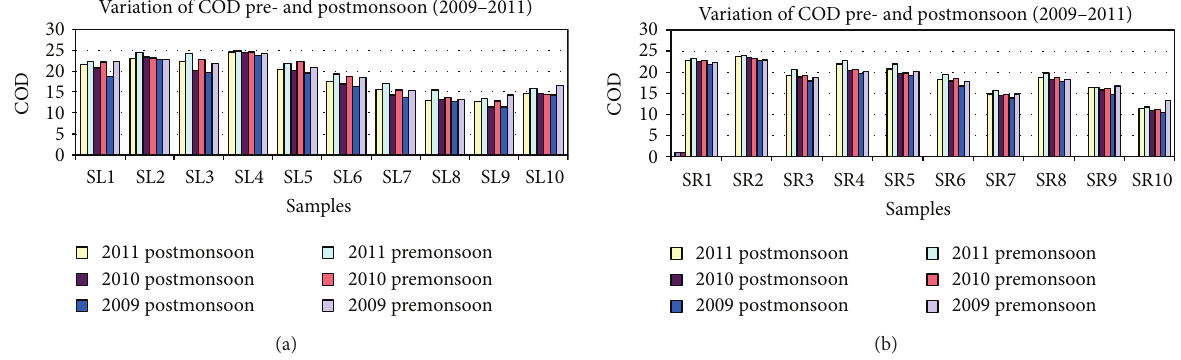
Figure 6: (a) Observations of COD in water from the sites SL1–SL10 for the pre- and postmonsoon of 2009–2011. (b) Observations of COD in water from the sites SR1–SR10 for the pre- and postmonsoon of 2009–2011.